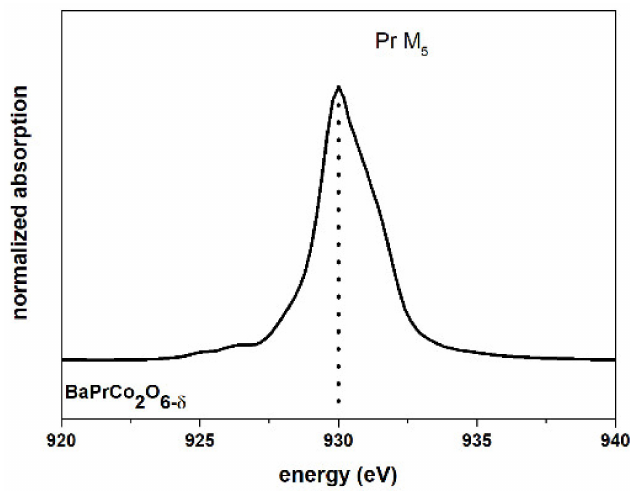
Figure 11. XANES praseodymium M 5 edge for BaPrCo 2 O 6 .